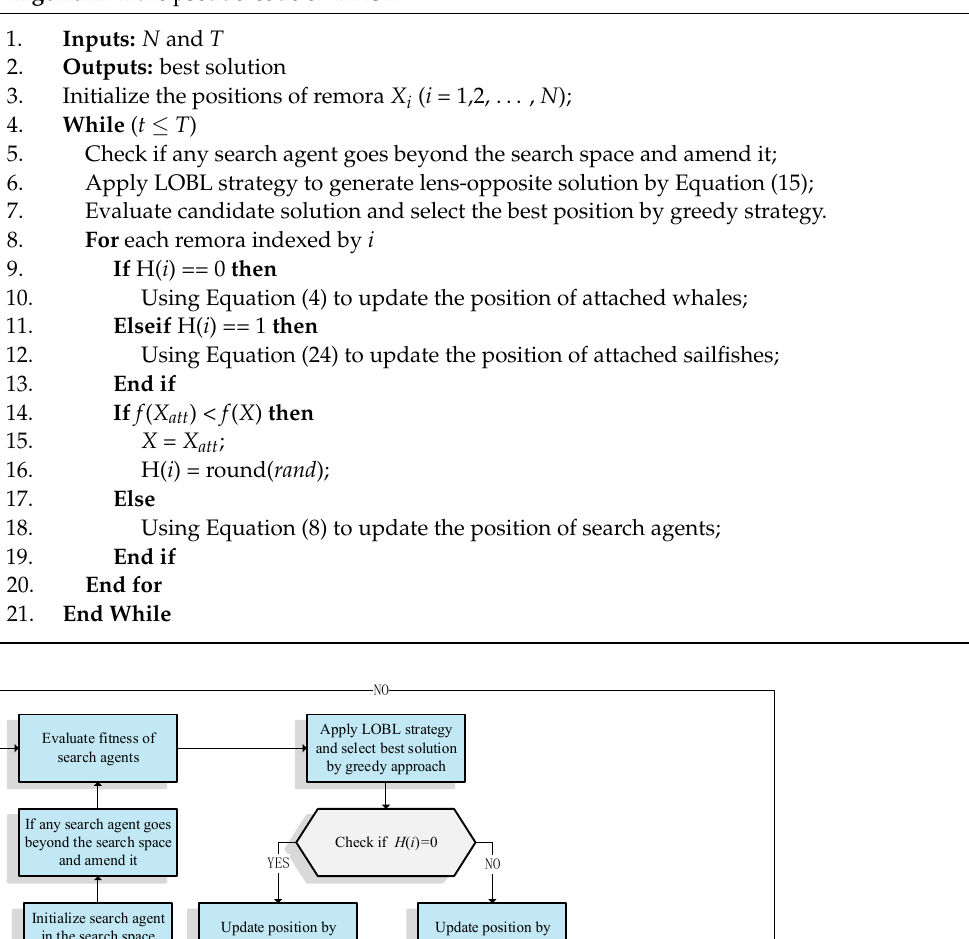
Algorithm 2 the pseudo-code of MROA